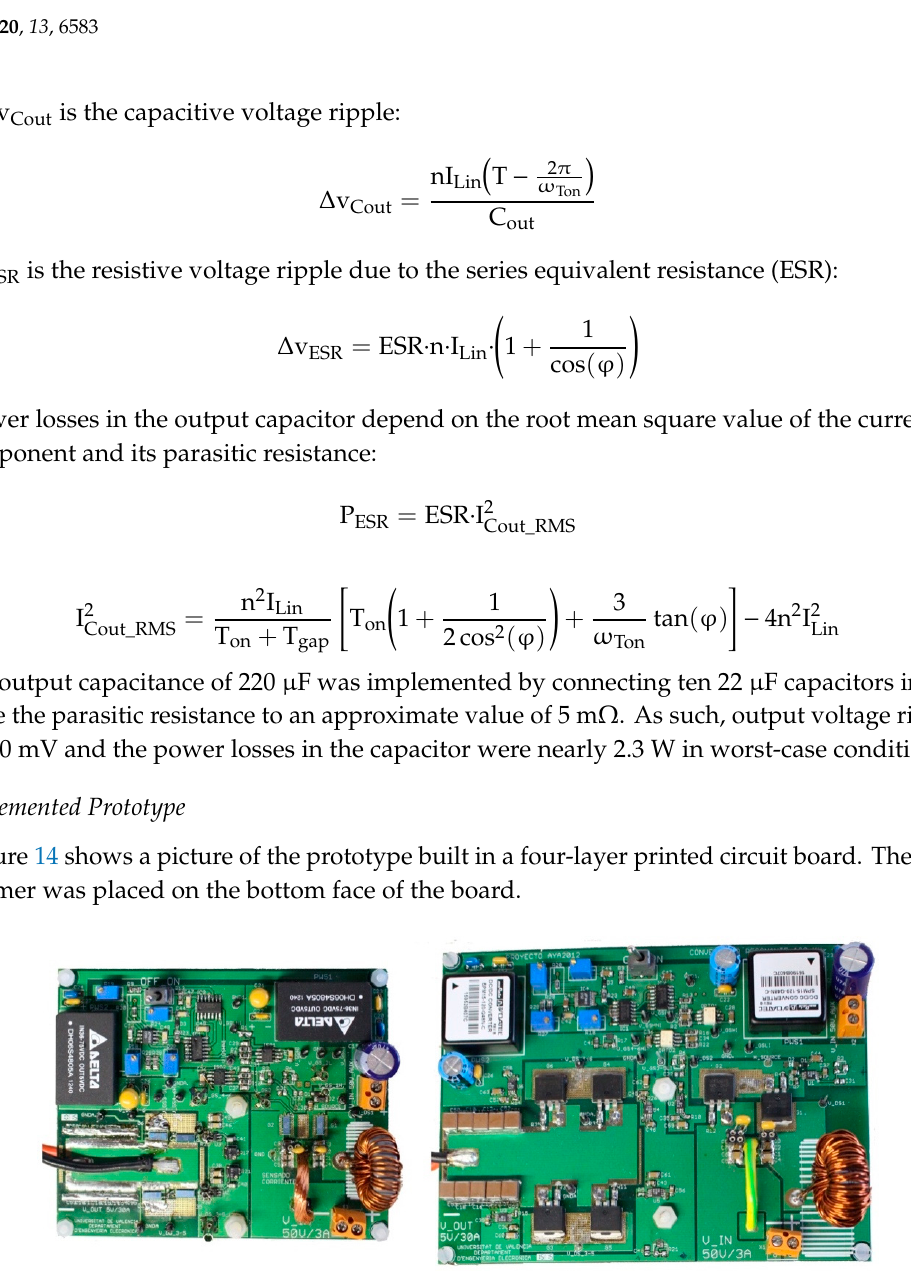
Figure 14. Implemented prototype of the IBC with ( a ) GaN HEMTs and ( b ) silicon MOSFETS. To ensure the cut-off of the synchronous rectifier transistors during the T gap time interval, a series connection of a diode and a small inductance was placed in the off path of the gate drive circuit during T gap without needing an auxiliary negative voltage source, as is shown in the oscillogram of Figure 16.